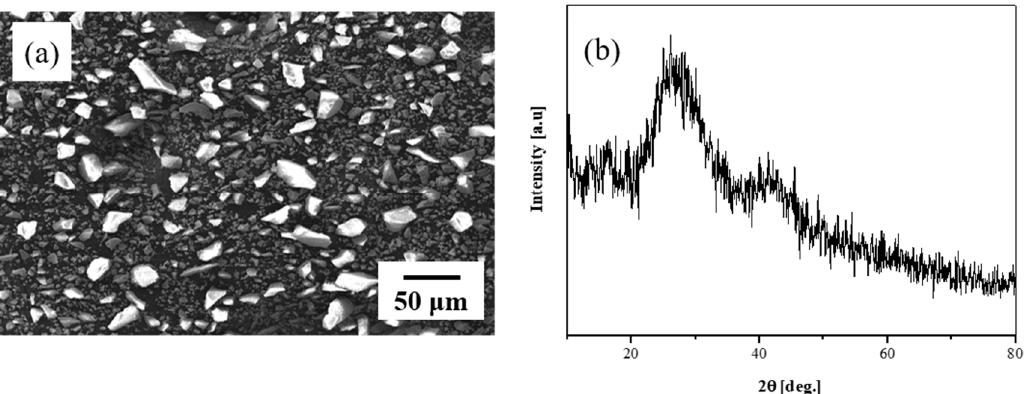
Figure 3. ( a ) Scanning electron microscope (SEM) image and ( b ) X-ray diffraction (XRD) results of synthesized glass frit.